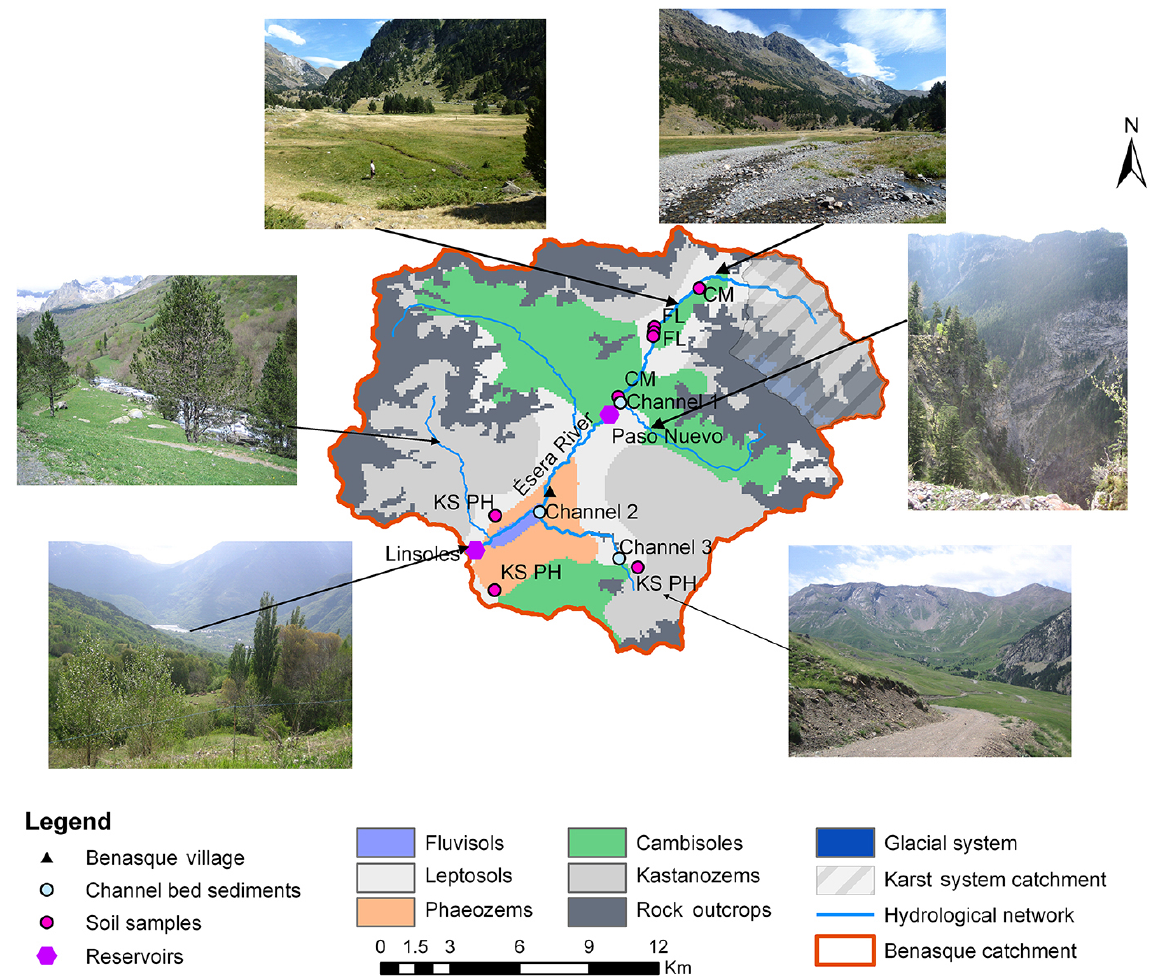
Figure 3. Distribution of soil and sediment samples in the Benasque